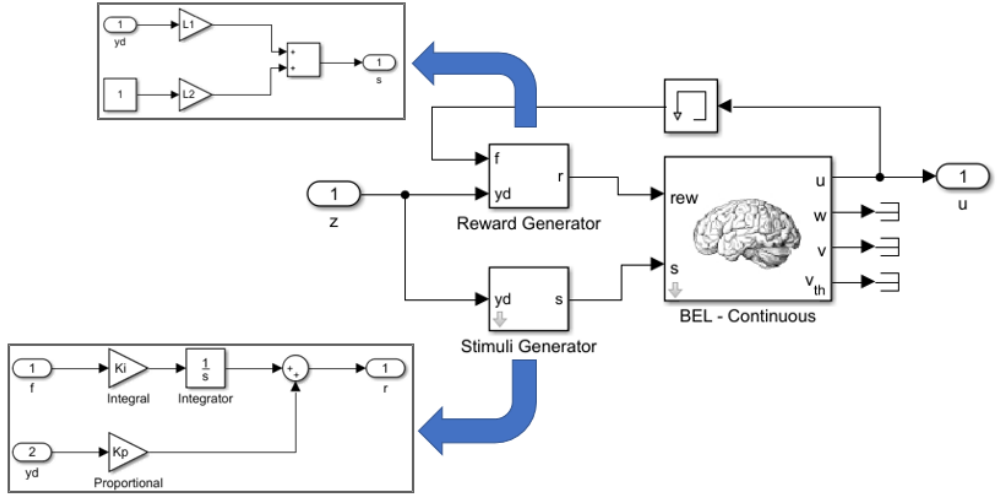
Figure 6. S IMULINK (cid:114) block diagram of the BEL-Based Intelligent Controller